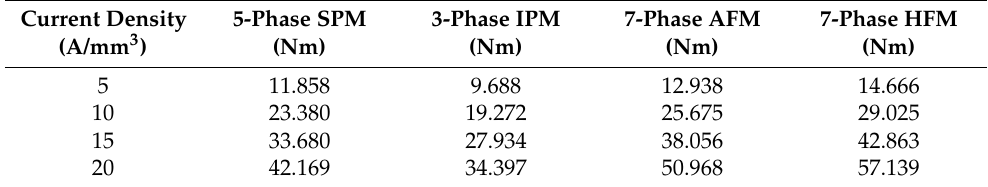
Table 4. The average output torque of four machines versus current densities.